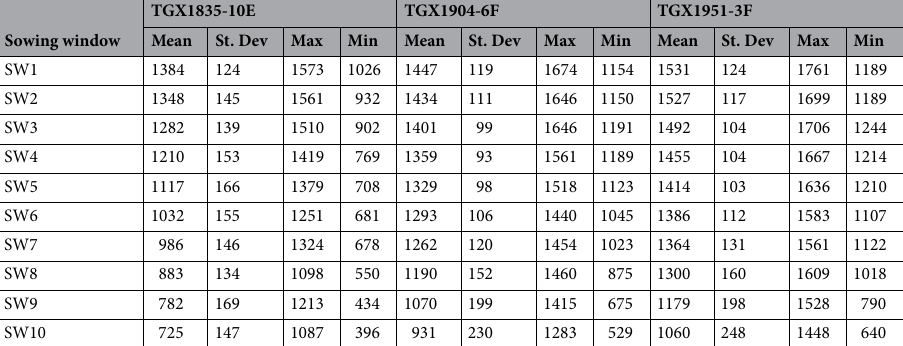
Table 7. Simulated grain yield (kg ha −1 ) of different sowing windows based on 30 ‐ year (1985–2014) seasonal analysis for soybean varieties (TGX1835 ‐ 10E, TGX1904-6F and TGX1951 ‐ 3F) in Jagiri (southern Guinea savanna). SW1: June 1–7; SW2: June 8–14; SW3: June 15–June 21; SW4: June 22–28 June; SW5: June 29–July 5; SW6: July 6–July 12; SW7: July 13–July 19; SW8: July 20–July 26; SW9: July 27–August 2; SW10: August 3– August 9.